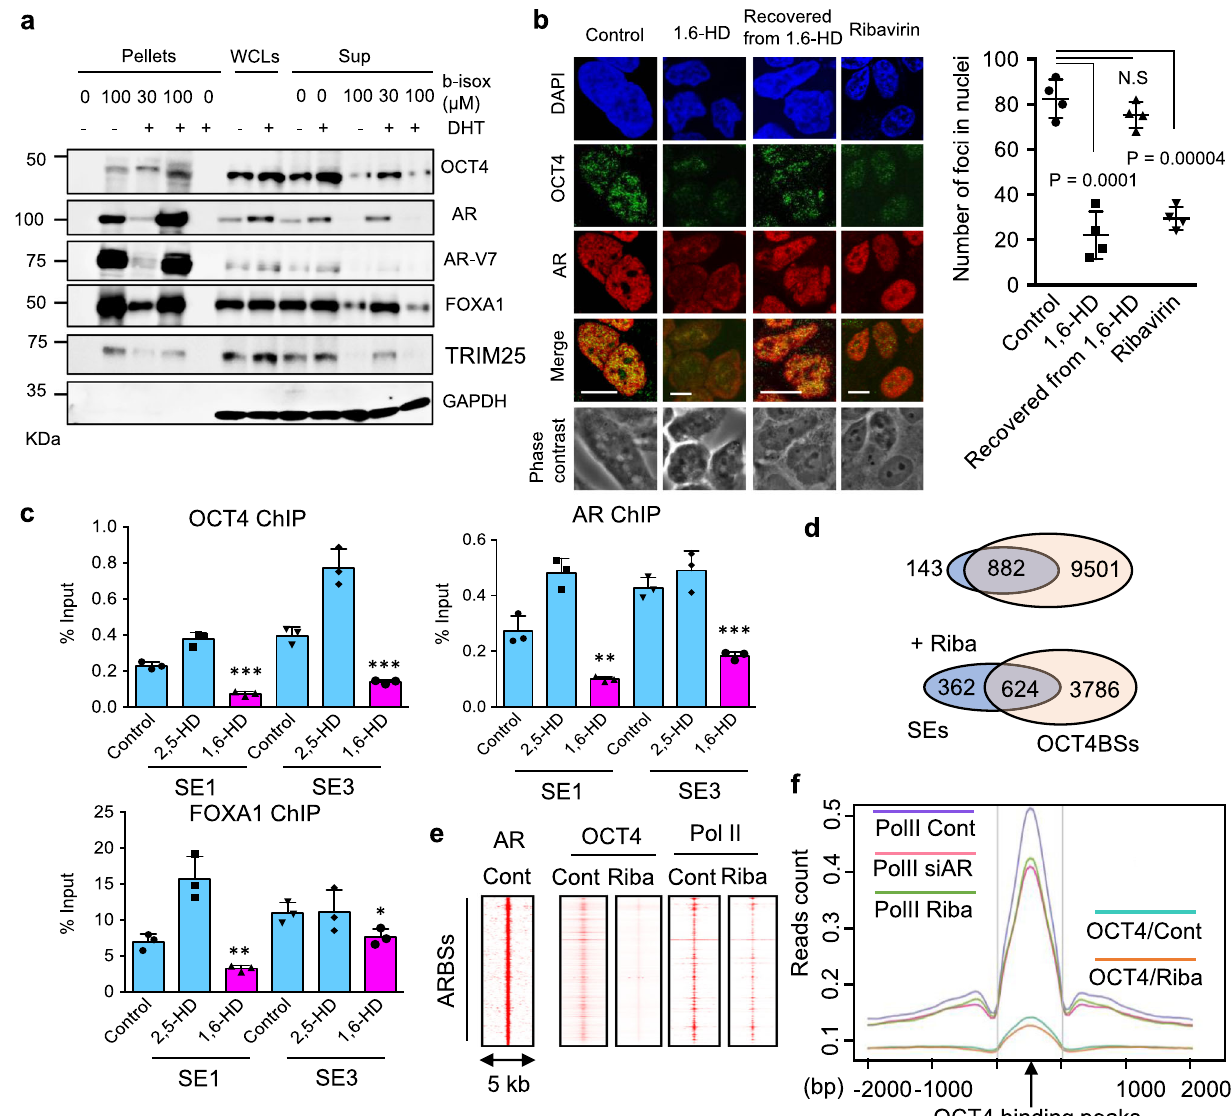
Fig. 4 The effect of 1,6-HD and a nucleoside analog ribavirin (Riba) on OCT4-occupied enhancer activity. a Immunoblots showing that AR, FOXA1, and OCT4 are precipitated by biotinylated isoxazole (b-isox). TRIM25, a representative RNA-binding protein, was used as a positive control. GAPDH was used as a negative control. WCLs: whole cell lysates, Sup: supernatants. b (Left) IF images of AR and OCT4 in 22Rv1 cells. Cells were treated with 1,6-hexandiol (HD) for 5 min, recovered for 1 h after 1,6-HD for 5 min, or ribavirin for 24 h. Bar = 10 μ m. (Right) Quanti fi cation of OCT4 puncta ( N = 4, biological independent cells) Two-sided t -test was performed. N.S not signi fi cant. Data are presented as average ± S.D. c ChIP analysis was performed in 22Rv1